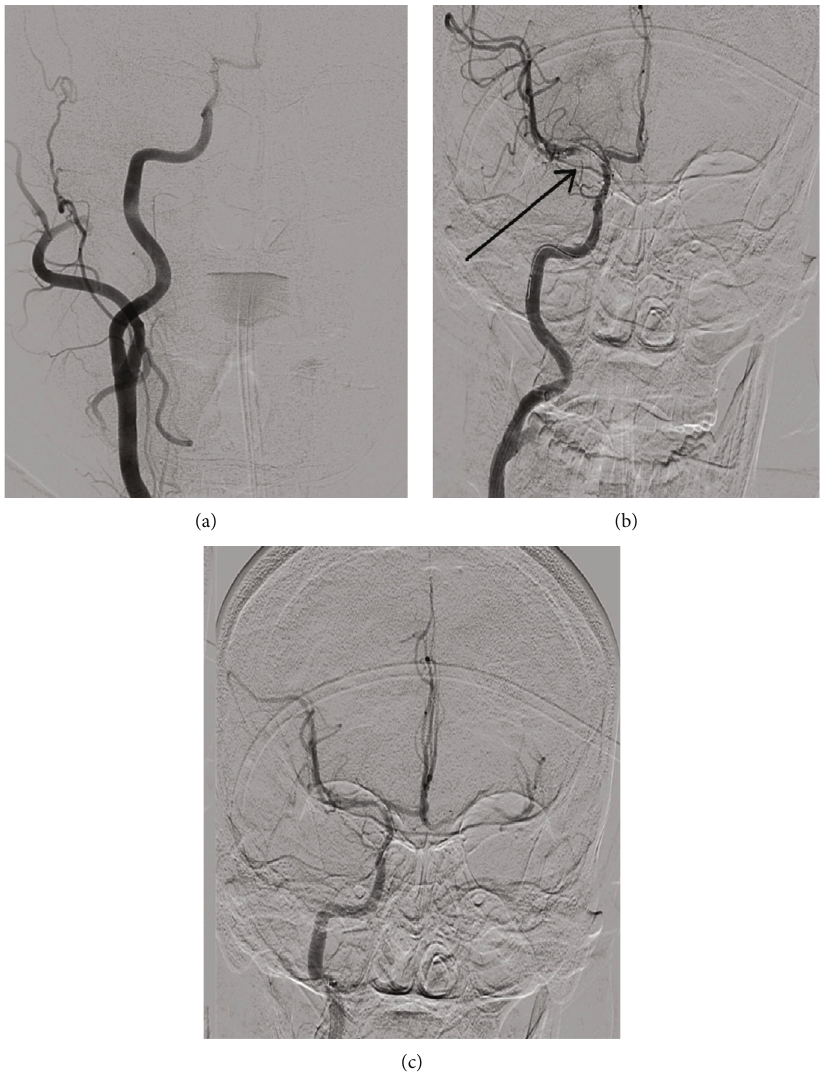
Figure 3: CT cerebral angiogram shows (a) distal ICA occlusion with non-visualization of M1 MCA, (b) stentriever in situ with left ICA run showing a fi lling defect in distal ICA proximal M1 MCA (arrow), and (c) complete recanalization of ICA